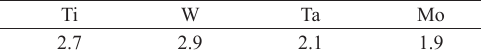
Table 1. Chemical composition of the NI-183 alloy measured by EDX (wt. %). Ni superalloy